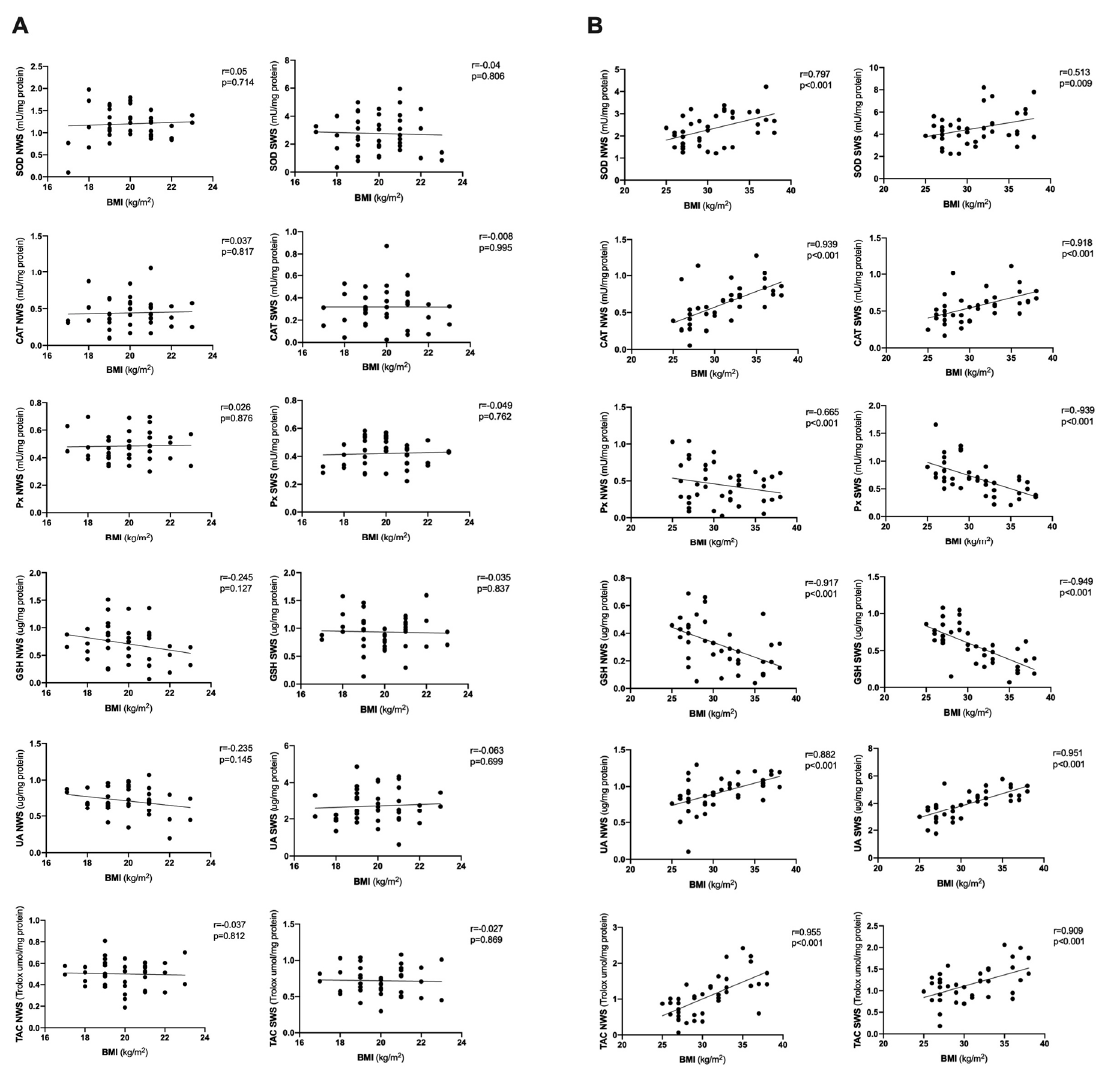
Figure 8. Correlations between BMI and salivary antioxidants in healthy children ( A ) as well as overweight and obese adolescents ( B ). BMI- body mass index, CAT- catalase, GSH- reduced glutathione, NWS- non-stimulated whole saliva, Px- salivary peroxidase, SOD- superoxide dismutase, SWS- stimulated whole saliva, TAC- total antioxidant capacity, UA- uric acid.